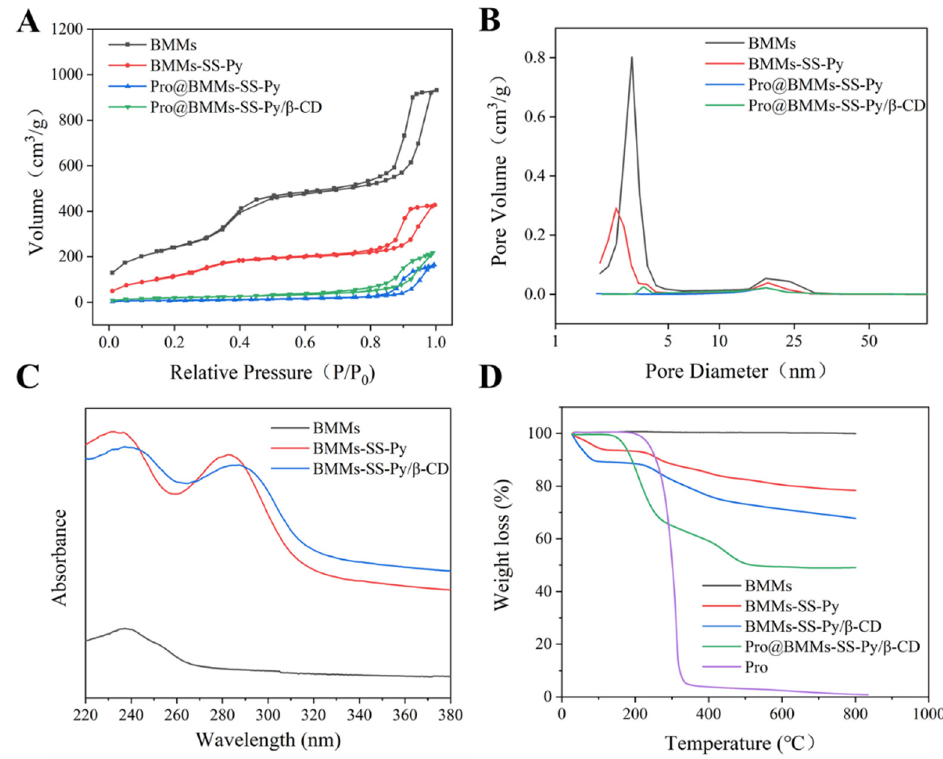
Figure 4. ( A ) BET isotherms, ( B ) pore size distribution curves, ( C ) UV–vis spectra, and ( D ) TGA curves of Pro@BMMs-SS-Py/ β -CD NPs and control samples. Table 1. Mesoporous structure characterization, size, and zeta potential of